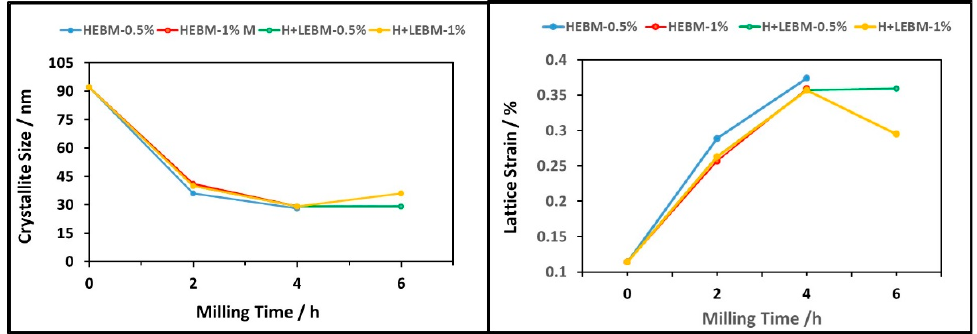
Figure 14. Variation in crystallite size and lattice strain in composite powders as a function of time for different milling routes.